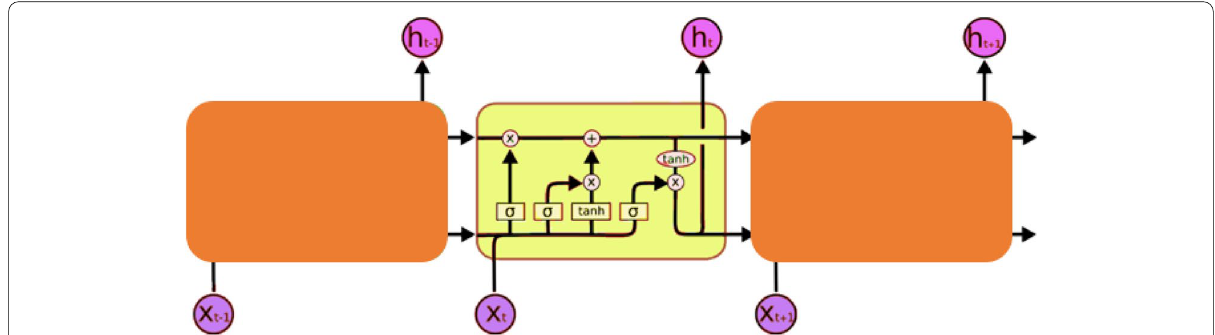
Fig. 4 Long short-term memory network. Source: Aibin, Michal.